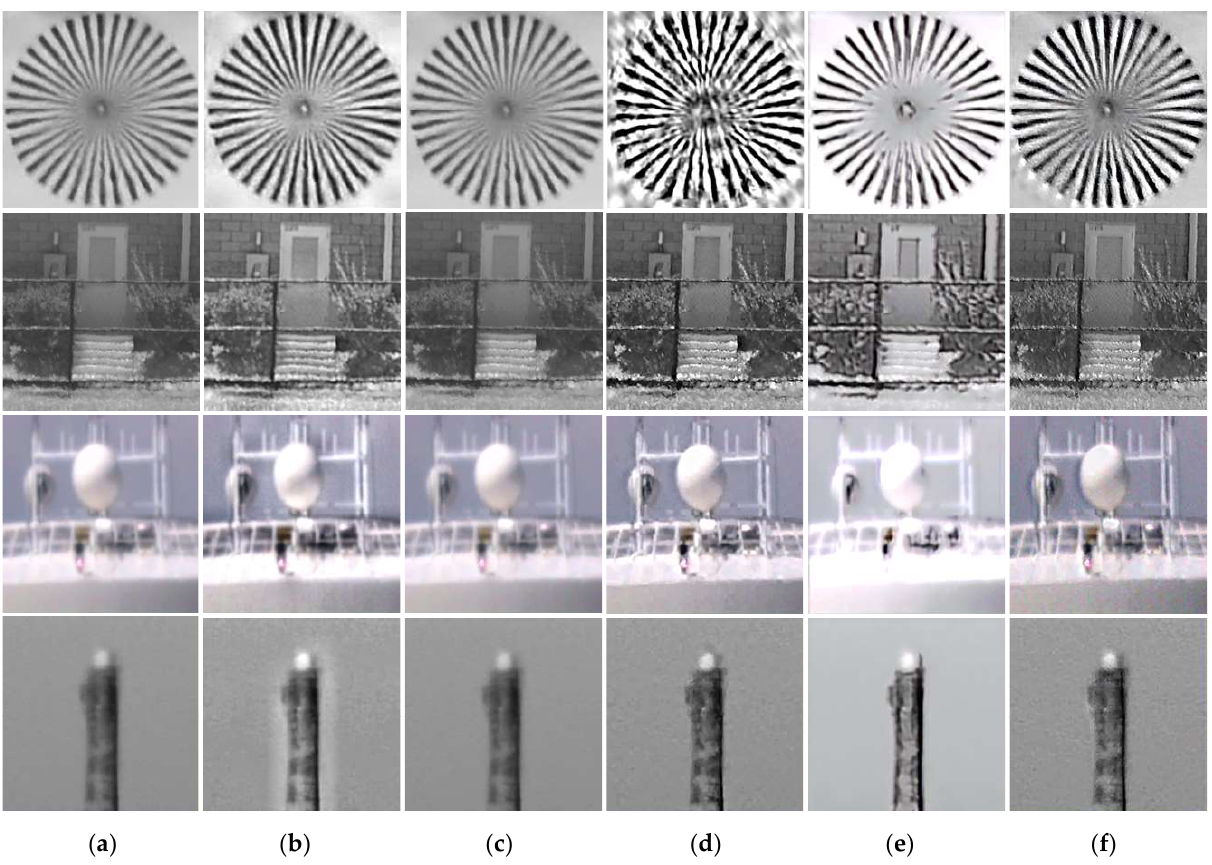
Figure 8. Restored results of real near-ground turbulence degraded images. ( a ) Degraded image; ( b ) CLEAR; ( c ) SGL; ( d ) IBD; ( e ) Gao et al.; ( f ) DTL (ours).